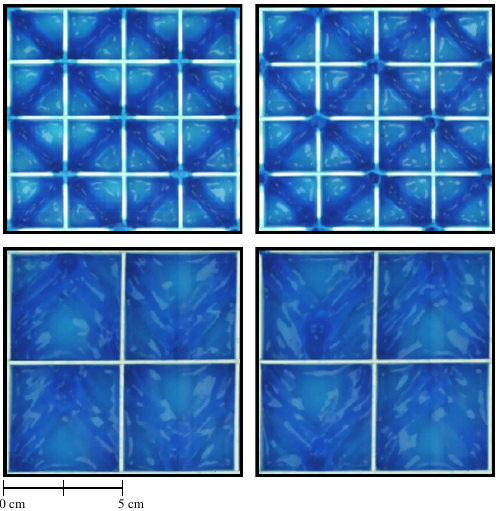
Figure 4. Top view images of a portion of the grid showing the resulting patterns at F = 12 Hz for cells of size l = 2.5 cm ( A = 1.3 mm; top images ) compared to those resulting for cells of size l = 5 cm ( A = 1.1 mm; bottom images